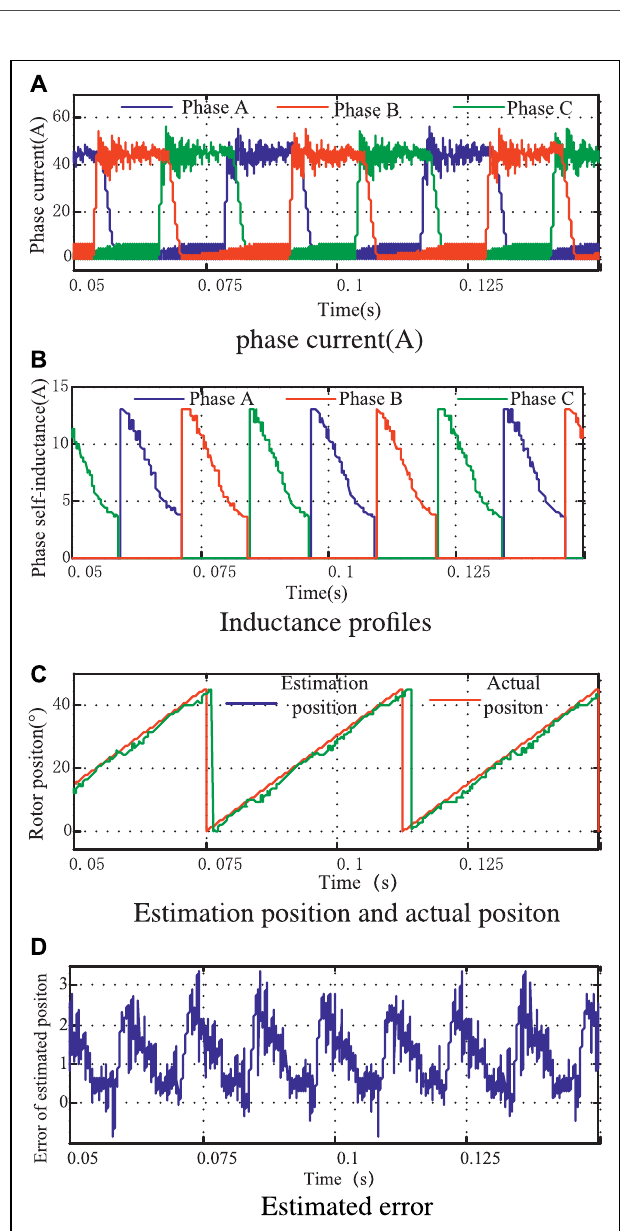
FIGURE 9 | Simulation results with proposed estimation under heavy load. (A) Profiles of phase current. (B) Phase inductance profile. (C) Estimation position and actual position. (D) Position error.